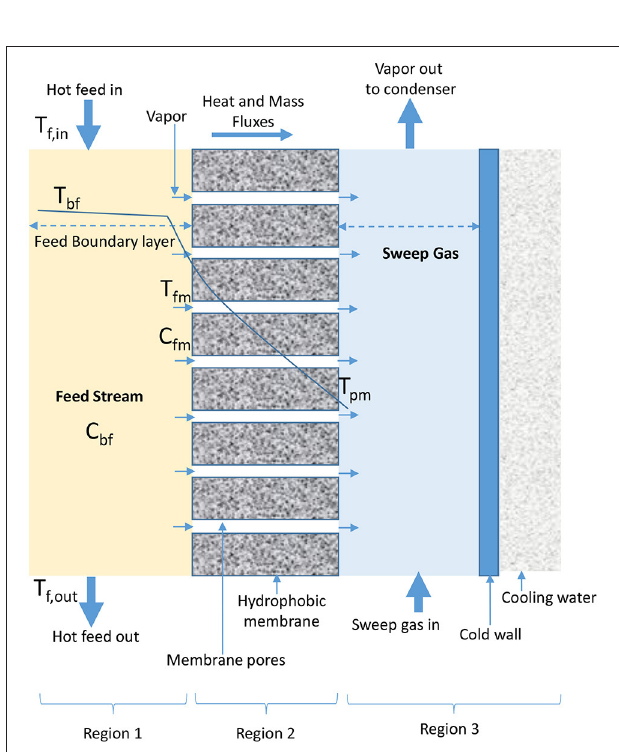
FIGURE 6 | Heat and mass transfer in TSGMD configuration.